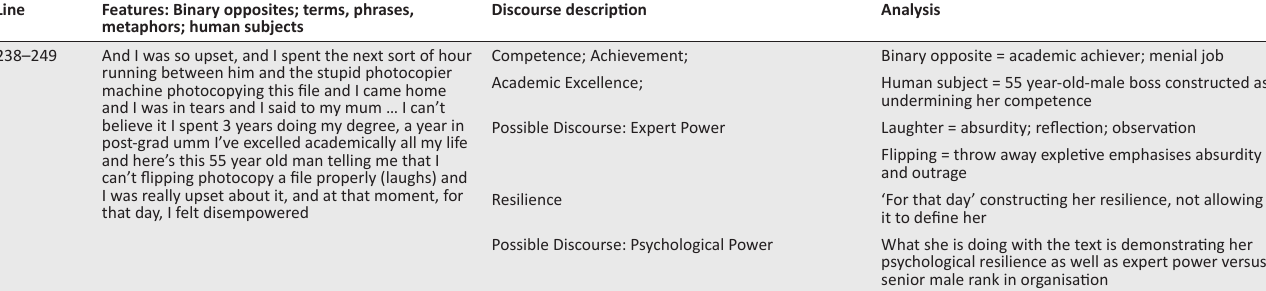
TABLE 2: Interview analysis grid – Research Objective one: To understand how women narrate their awareness of power.